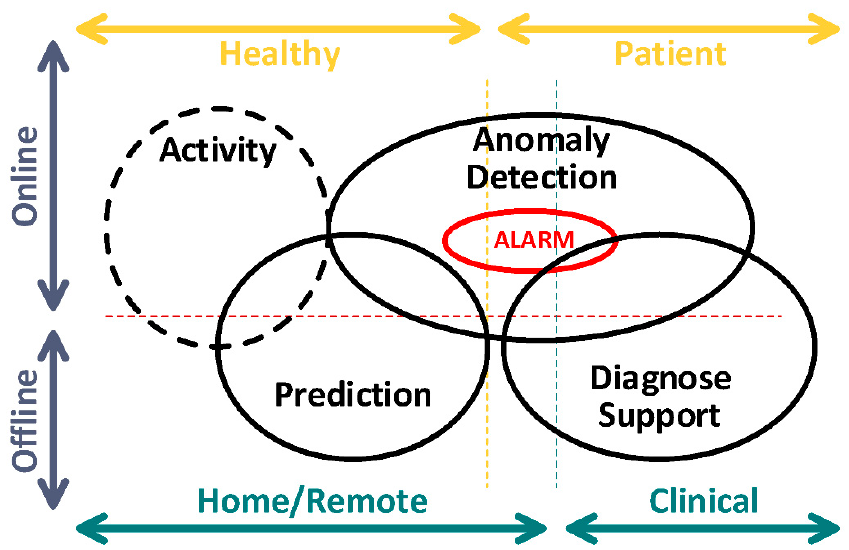
Figure 6. Scenario for vital sign acquisition: home, remote or clinical environment (modified from [96]).